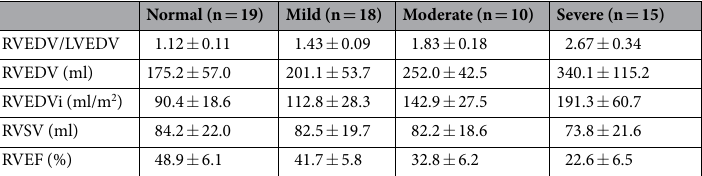
Table 2. CMR-derived RV/LV volume ratio, RV volumes, and EF stratified by category. Data is presented as mean ± standard deviation. RVEDV, right ventricular end-diastolic volume; LVEDV, left ventricular end-